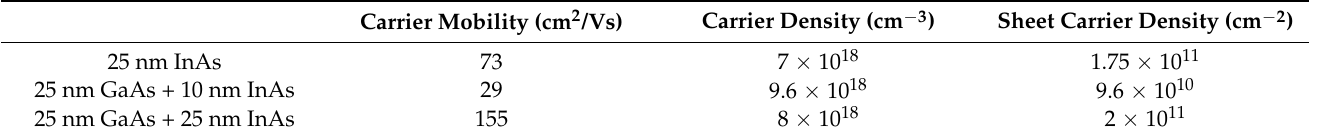
Table 1. Room-temperature Hall effect measurement results of poly InAs films 10 or 25 nm in nominal thickness, with or without prior 25 nm poly GaAs buffer layer, grown on glass. Carrier type for all films was found to be electrons. Carrier Mobility (cm 2 /Vs) Carrier Density (cm − 3 ) Sheet Carrier Density (cm − 2